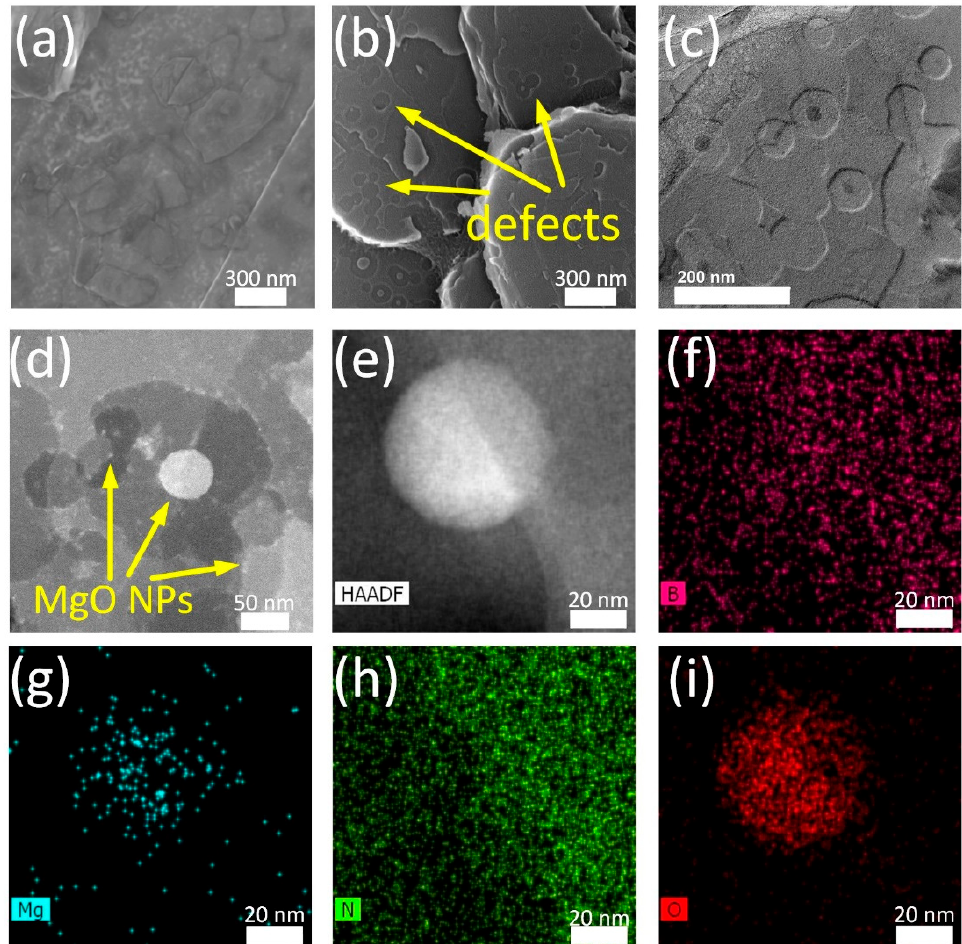
Figure 2. SEM ( a , b ), TEM ( c ), and HAADF STEM ( d , e ) images and corresponding EDXS elemental maps ( f – i ) of BN m ( a ) and BN a ( b – i ) samples. maps ( f – i ) of BN m ( a ) and BN a ( b – i )